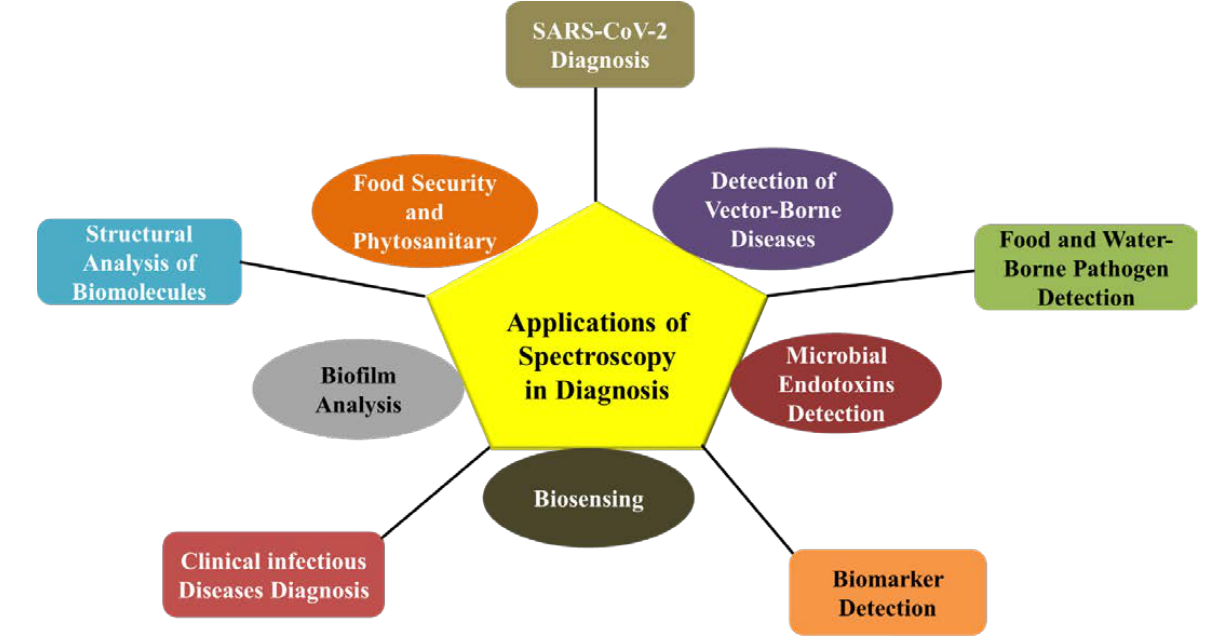
Figure 3. Overview of applications of spectroscopy in